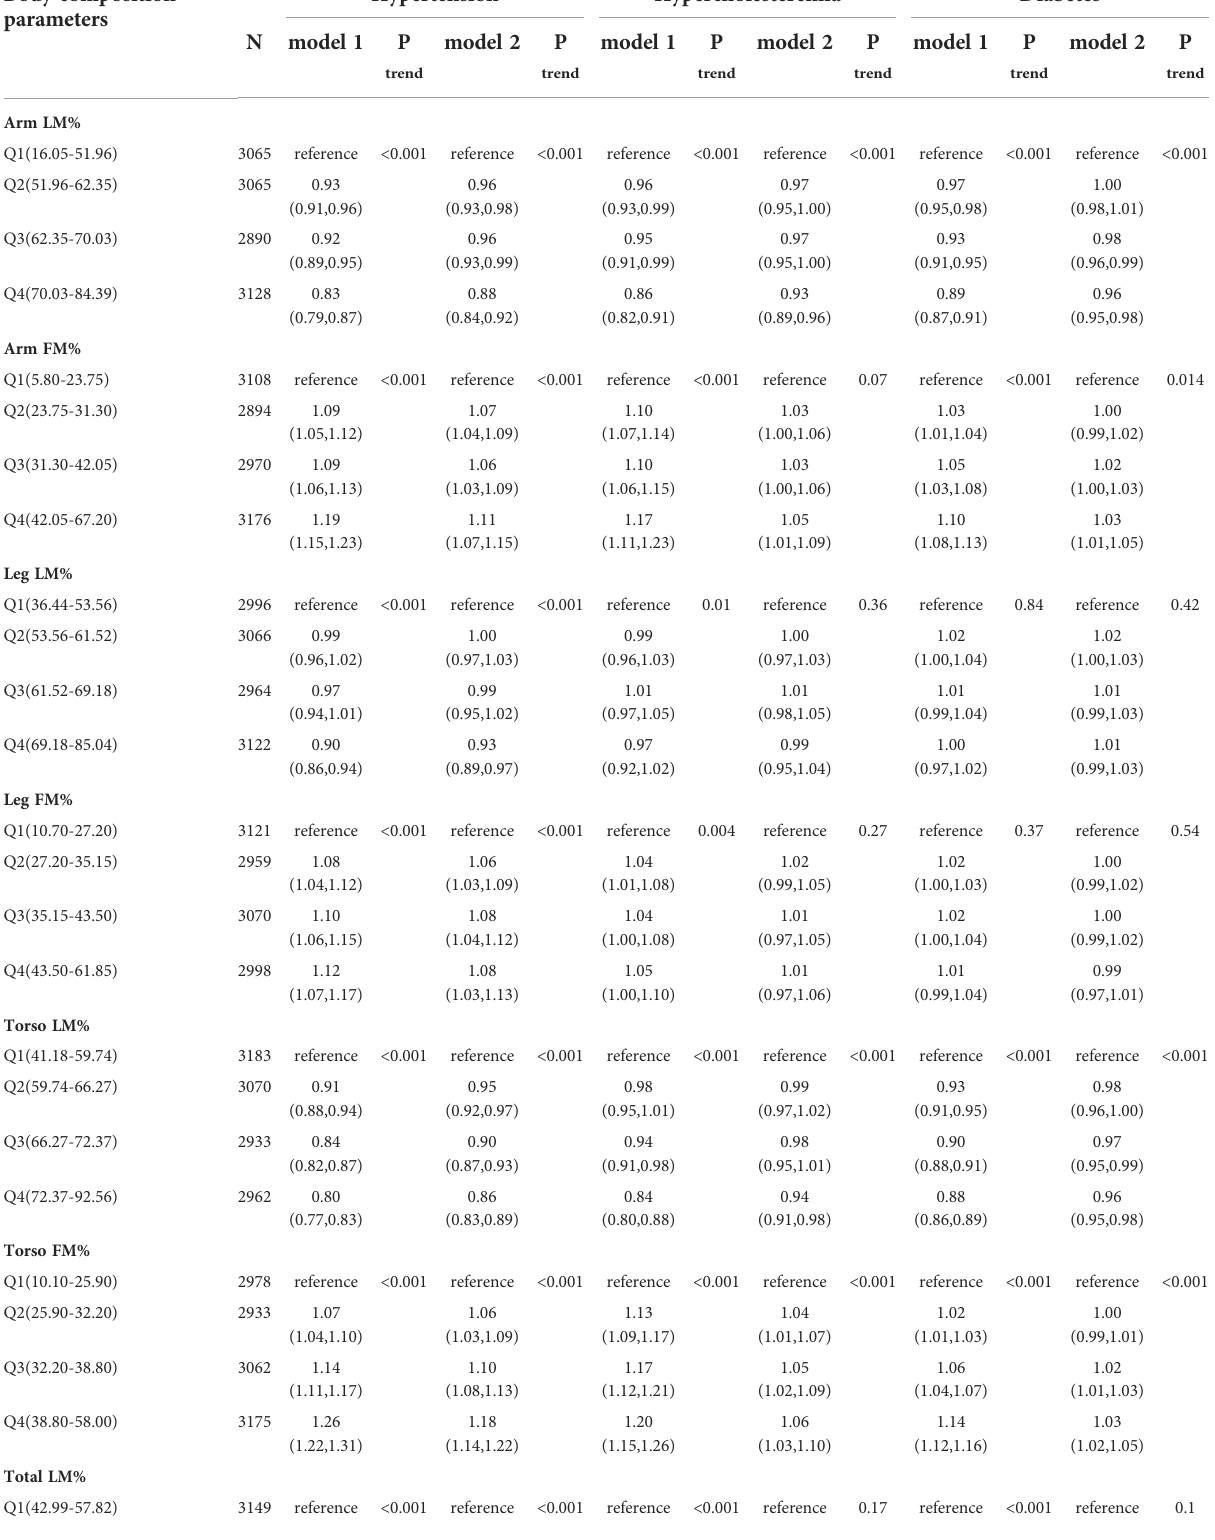
TABLE 2 Associations of body composition parameters with Hypertension, Hypercholesteremia, Diabetes in NHANES 2011-2018. Body composition